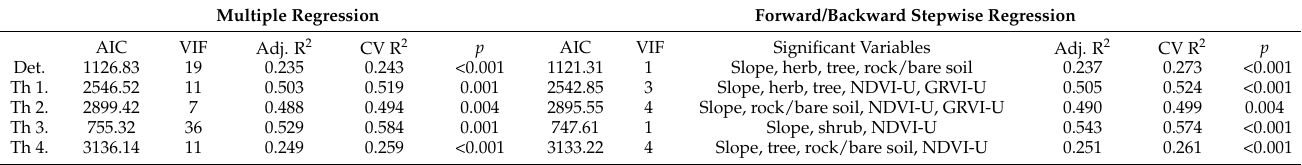
Table 5. Multivariate regression results. Cross-validated (CV) R 2 are 10-fold. Variance inflation factor (VIF) is maximum reported for